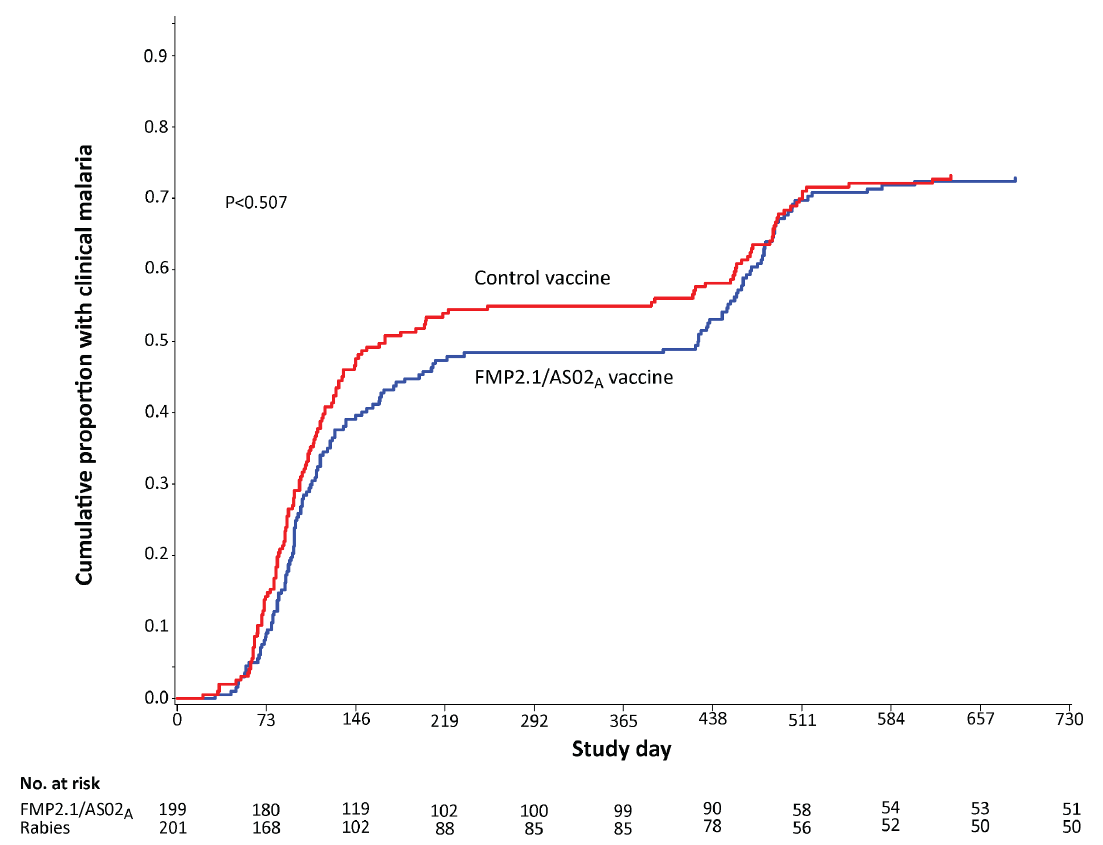
Figure 3. Cumulative incidence of first clinical malaria episode by treatment group during the entire follow-up period (study days 0–730), intention-to-treat. doi:10.1371/journal.pone.0079323.g003 DNA. The entire 1861 base pair ectodomain coding sequence of the ama1 gene was amplified using a previously described nested PCR [29]. Sequences were edited and aligned using 3D7 (Genbank number AF512508) as the reference sequence.